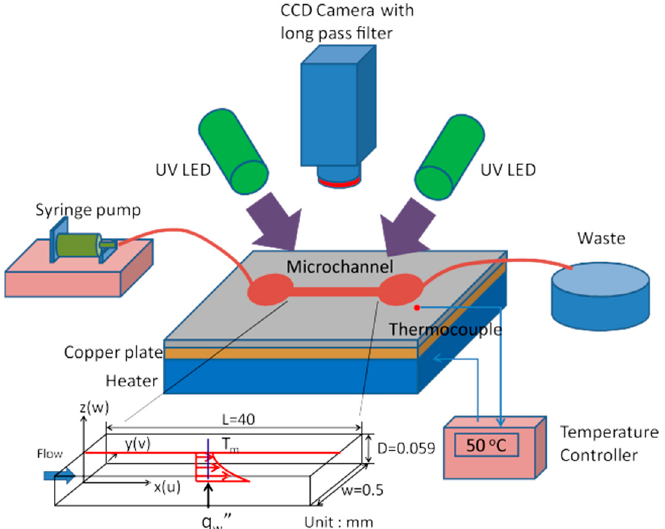
Figure 16. Experimental setup of Huang et al. for temperature measurement inside a microchannel by TSP thermometry [ 105 ] . Reprinted by permission from Ref. [ 105 ] , Journal of Micromechanics and Microengineering, Copyright © 2022 IOP Publishing Ltd.